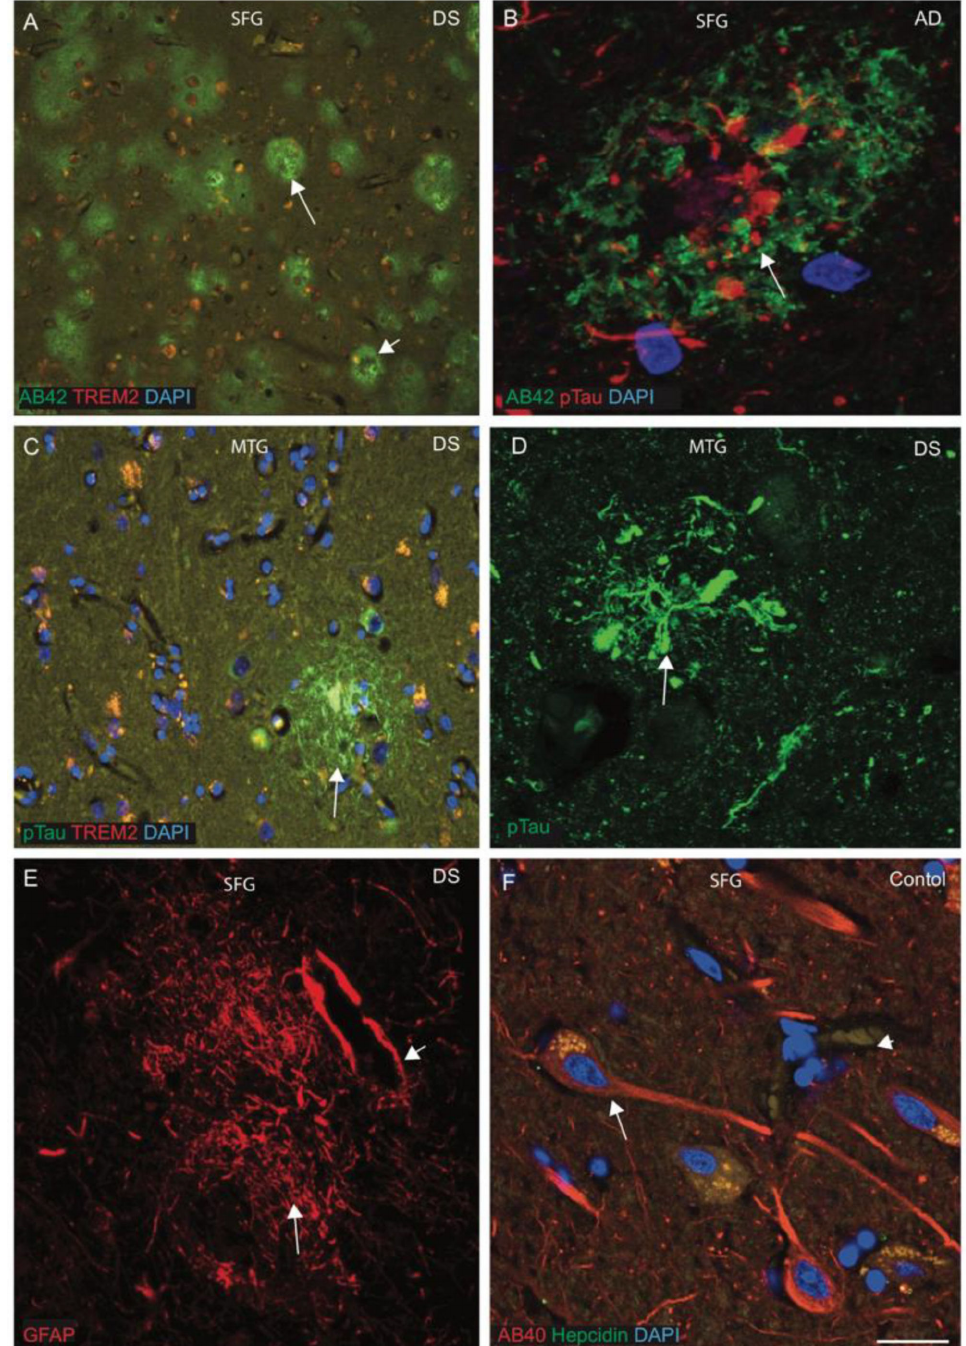
Figure 1. Characterisation of senile plaques (SP) in DS brain. To characterise the SP formation, the DS, AD and